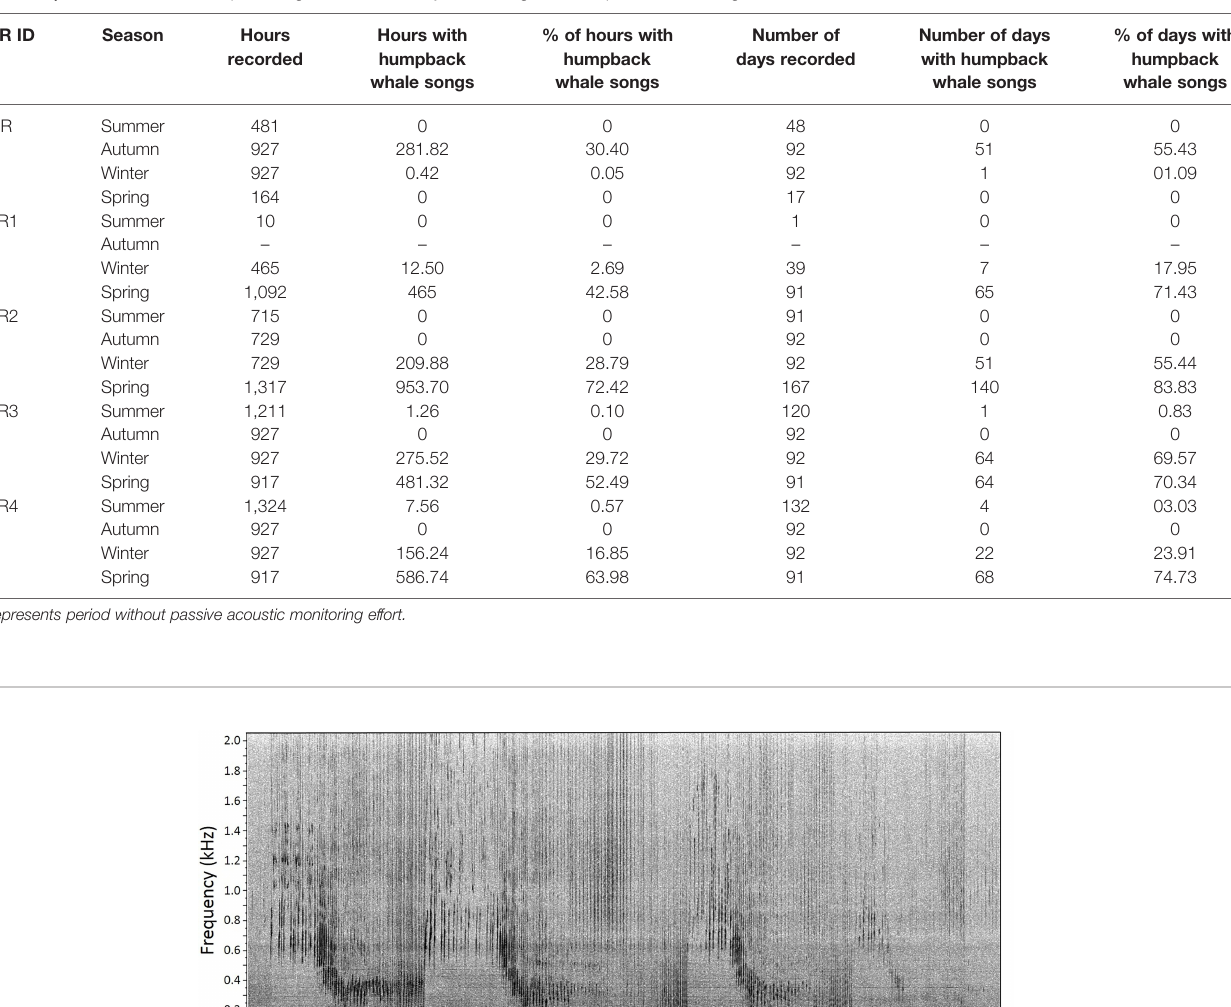
TABLE 2 | Seasonal number and percentage of hours and days containing male humpback whale songs off the west coast of South Africa and the Maud Rise, Antarctica.